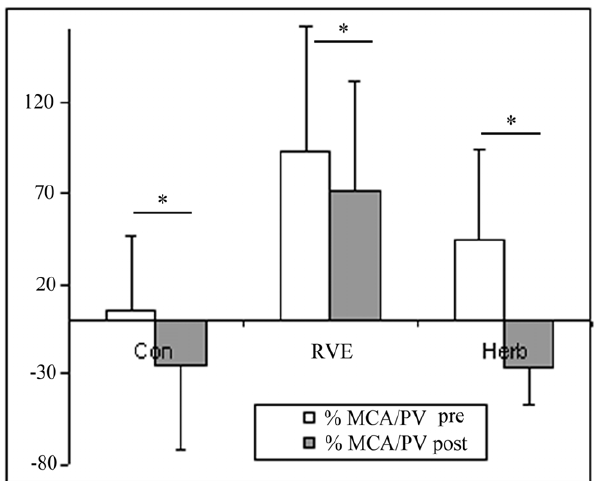
Figure 5. Ratio of flow of the cerebral vein to portal vein (MCA/ PV). The cerebral-to-splanchnic flow ratio confirmed that only RVE countermeasures contributed to redistribute the cardiac output in favor of the brain area.